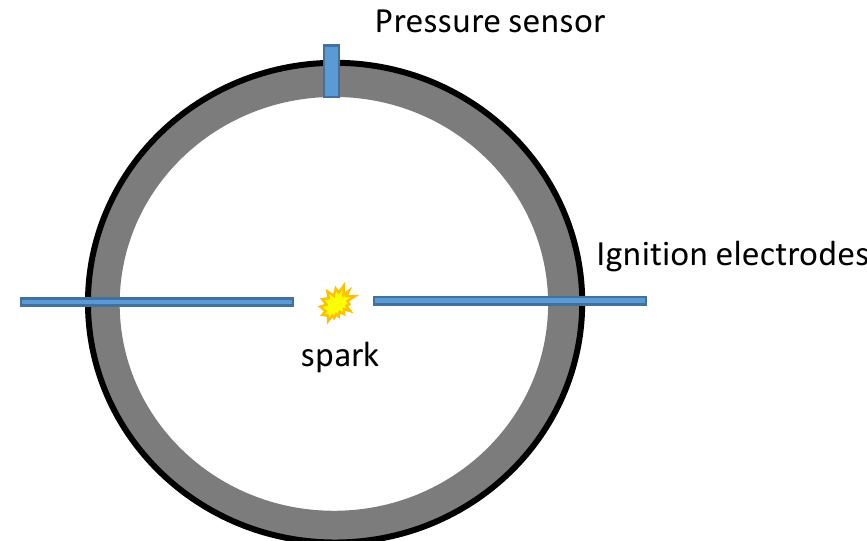
Figure 1. Sketch of the spherical bomb ignition system and a wall pressure sensor. These experiments were simulated with the model presented in the previous